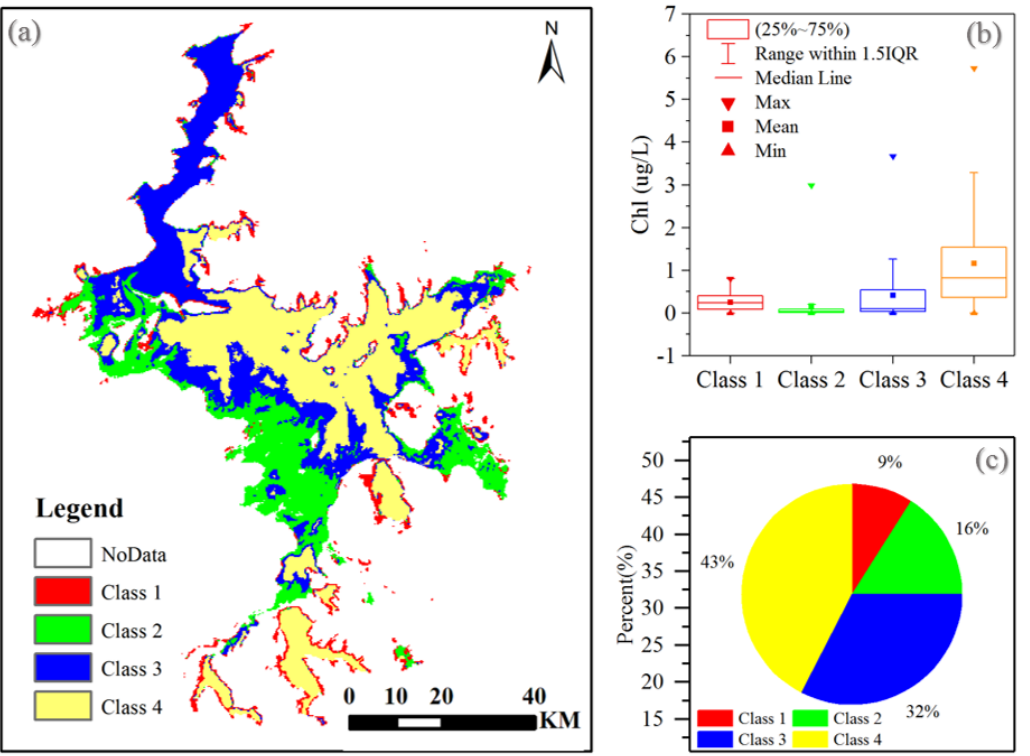
Figure 4. Classification of time series (2003–2012) MERIS derived Chl-a images: ( a ) 4 classes obtained from K-means cluster; ( b ) Chl-a range of each class; ( c ) area percentage of each class.